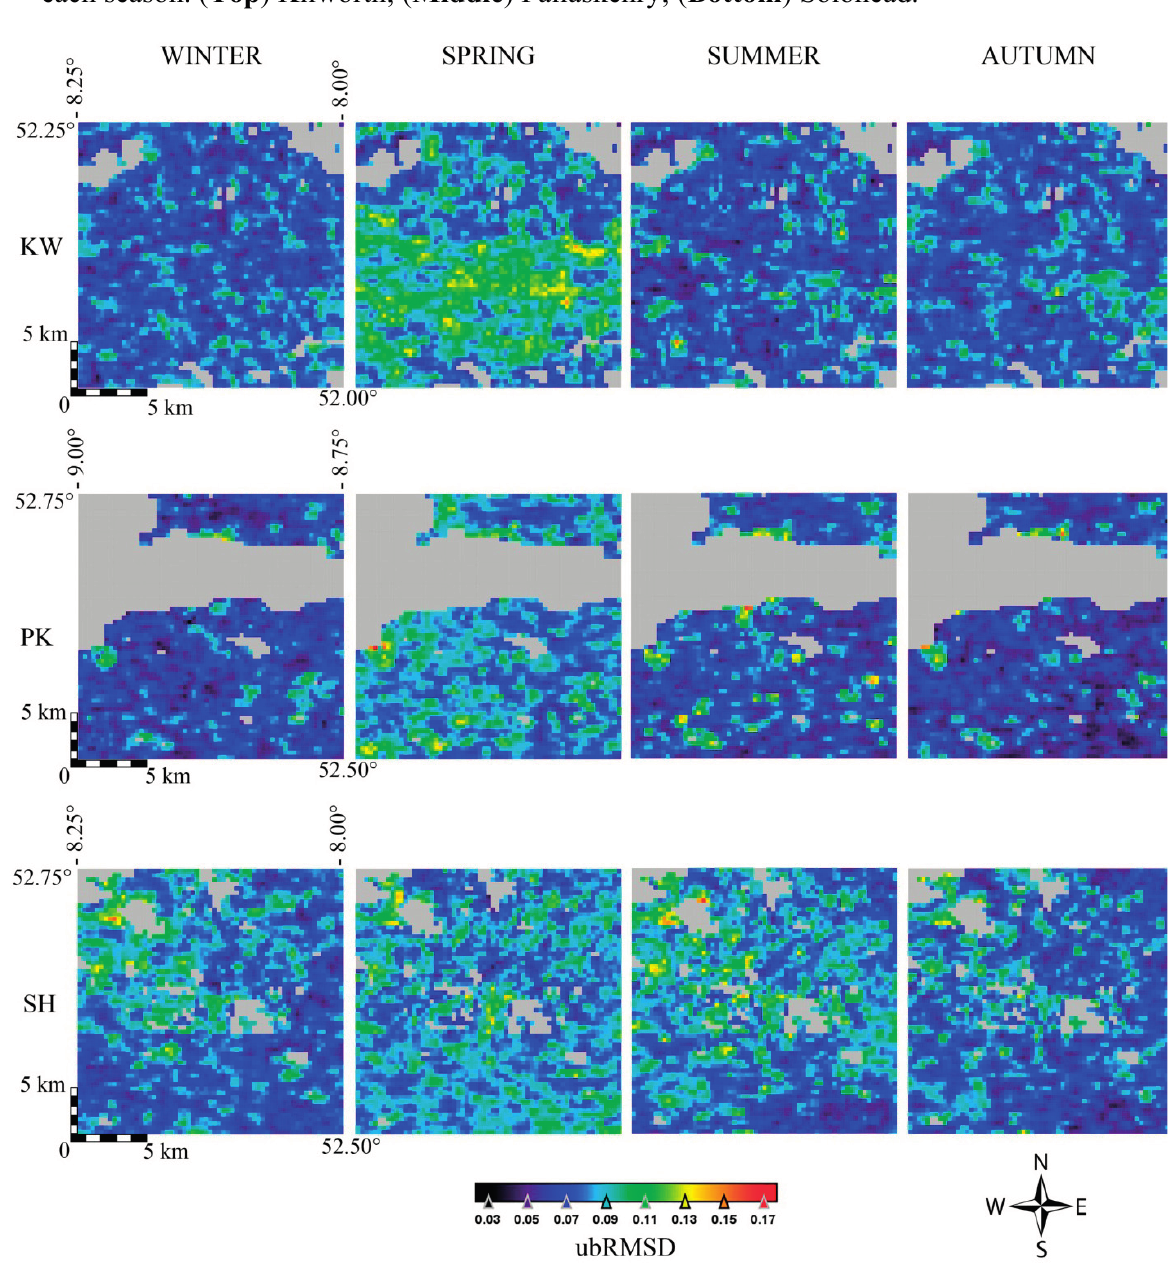
Figure 8. ASAR SM vs. ECV SM ubRMSD maps evaluated for each ASAR pixel and in each season. ( Top ) Kilworth; ( Middle ) Pallaskenry; ( Bottom )